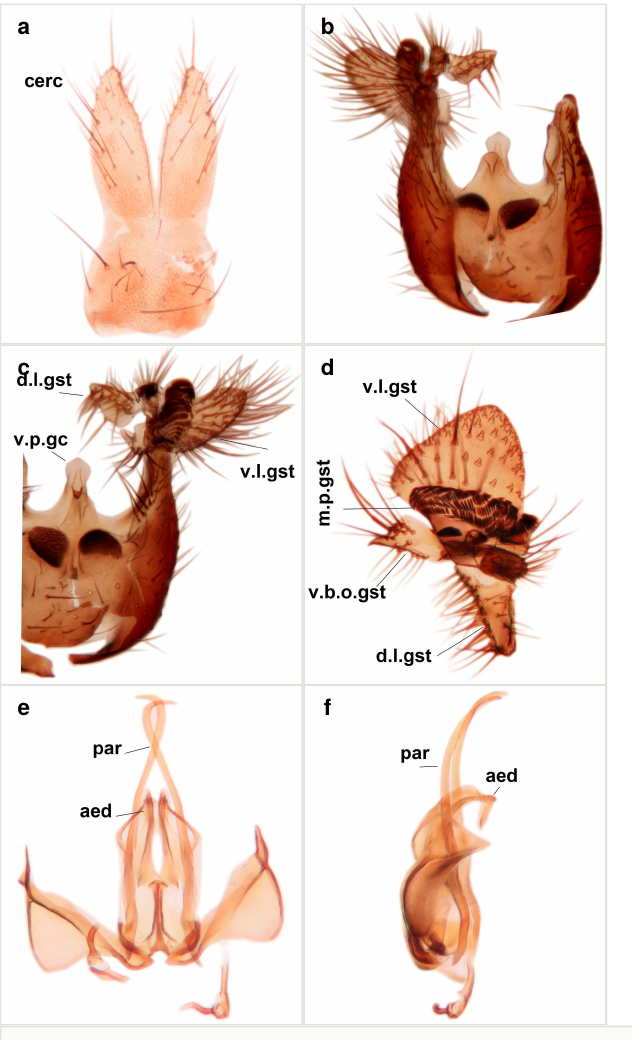
Figure 14. Phronia prolongata Salmela sp.n., holotype male, hypopygium. a : Cerci, dorsal